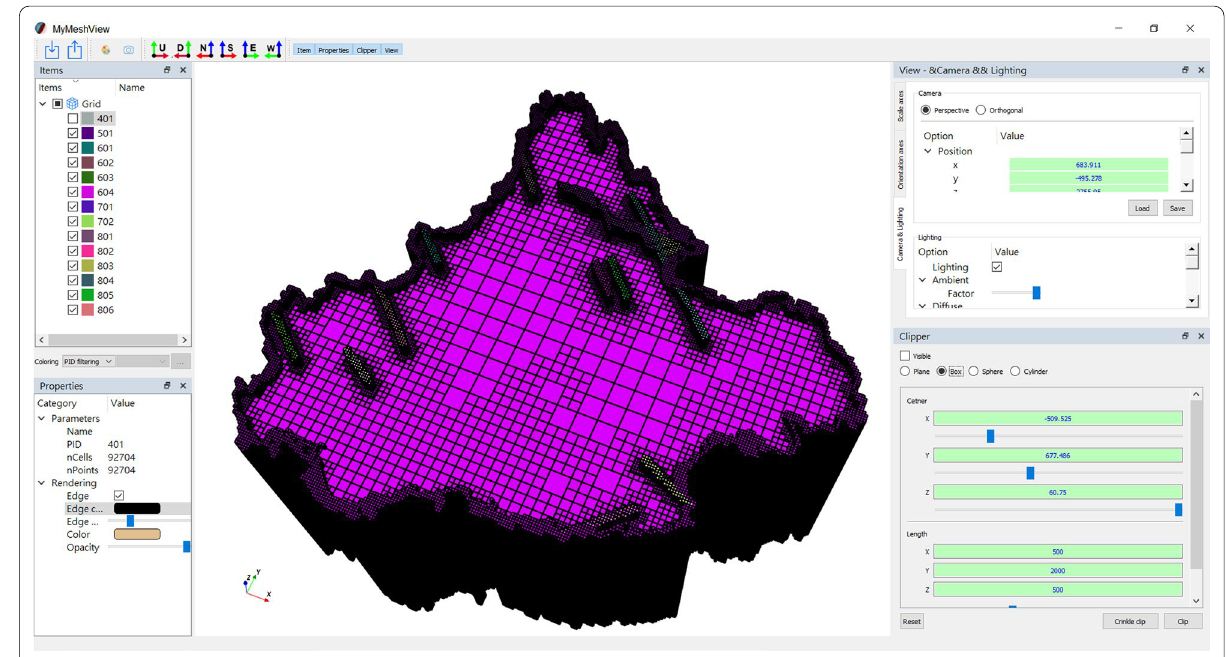
Fig. 9 MyMeshView’s user‑friendly